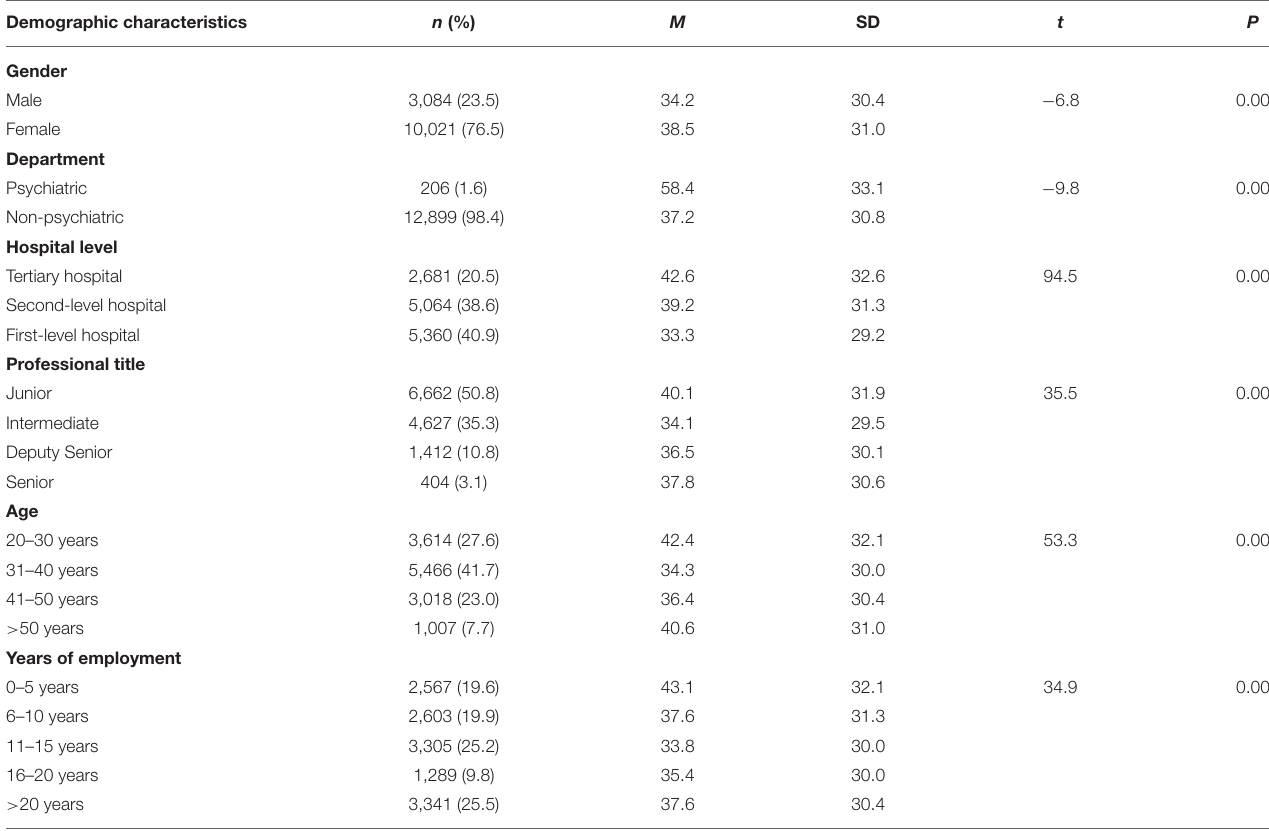
TABLE 1 | The descriptive characteristics of the participants. Demographic